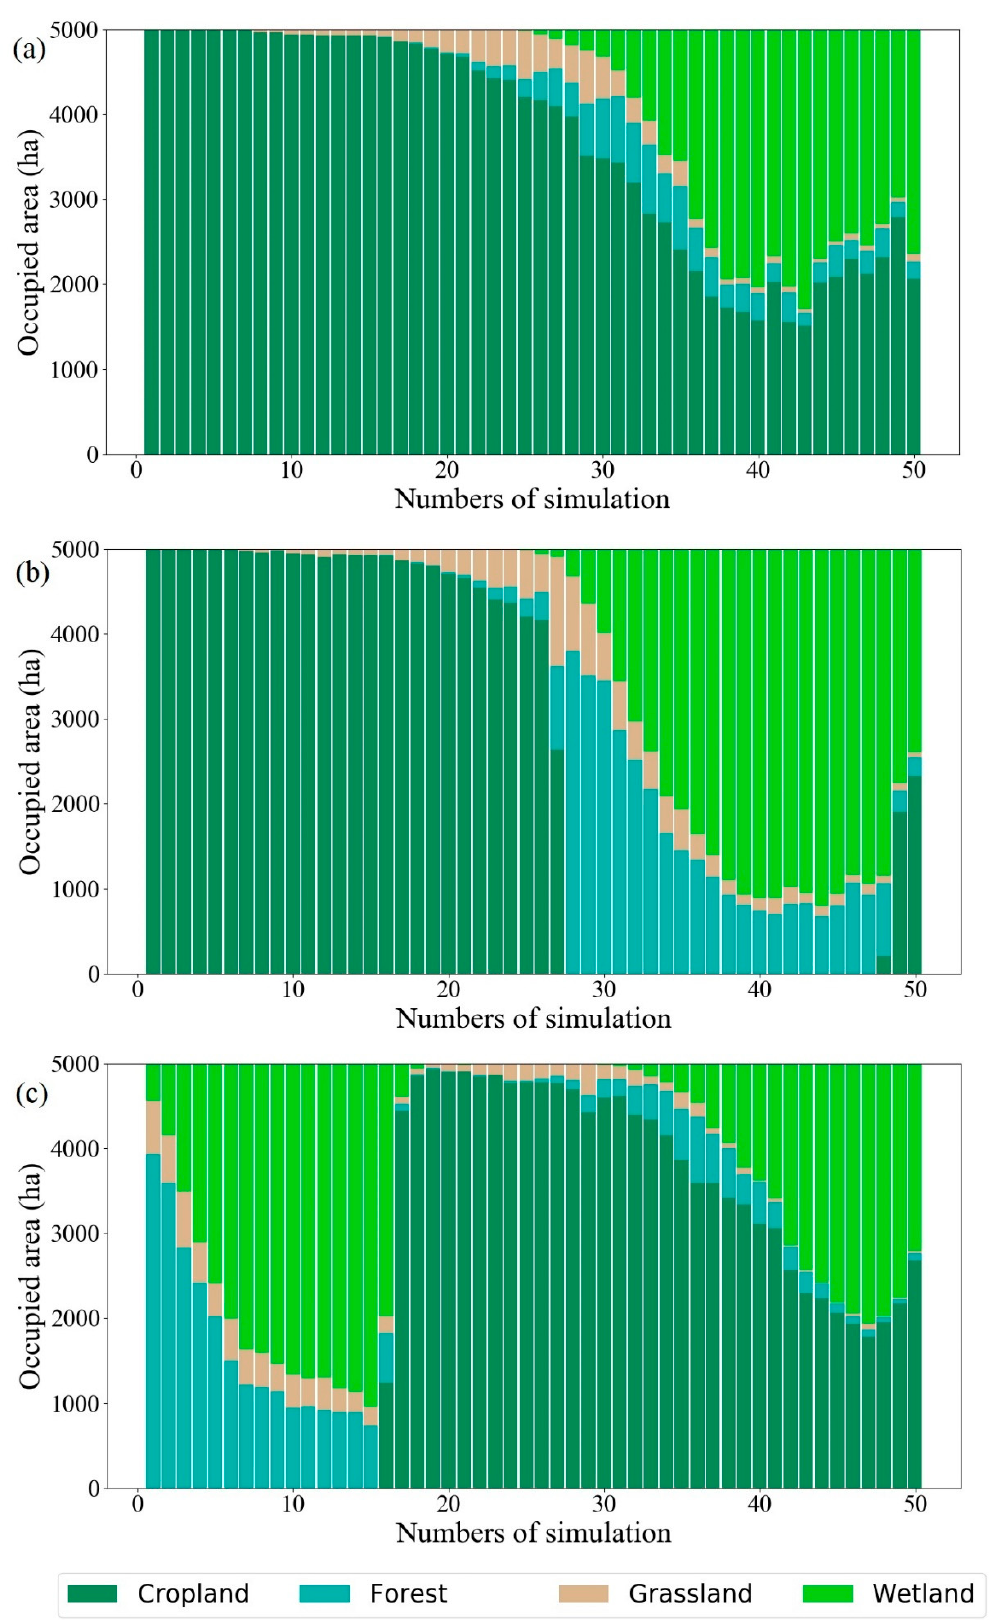
Figure 3. The quantity of ecological land loss in each simulation in the scenarios of: ( a ) business as usual (BAU); ( b ) land use planning (LUP); and ( c ) cropland protection (CLP).